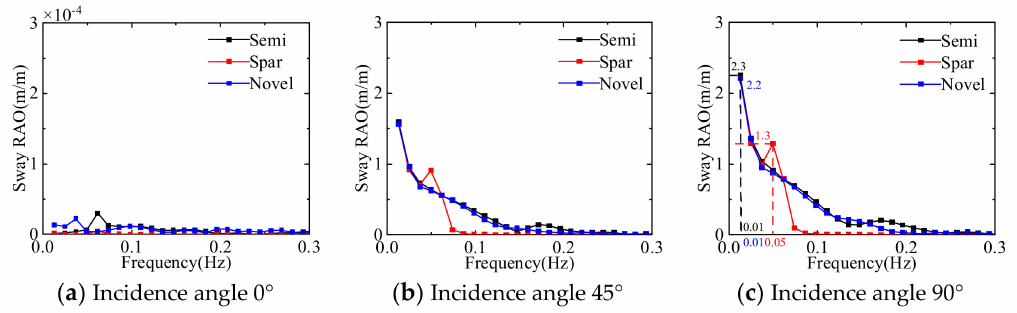
Figure 21. Comparison of the response amplitude operator in sway direction of three floating